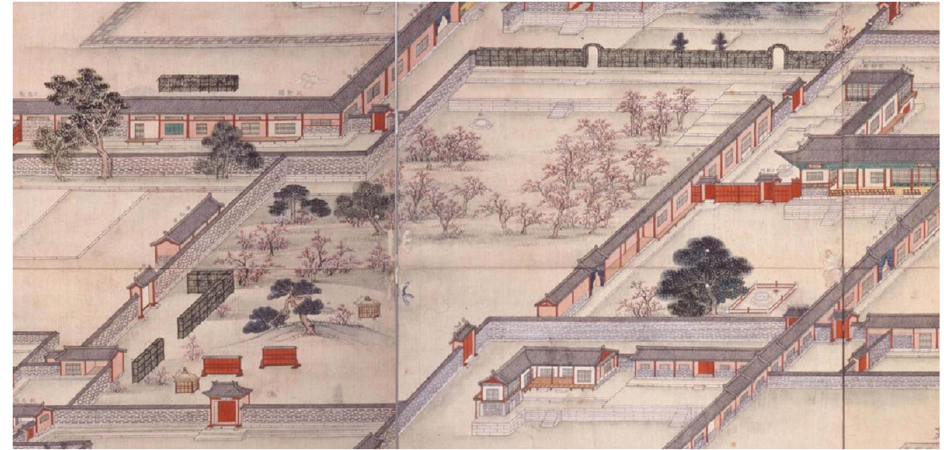
Figure 2. The palace orchard as seen in Donggwoldo painting, 1828–1830. Ink and colors on silk, 584 cm × 273 cm. Korea University Museum, Seoul.